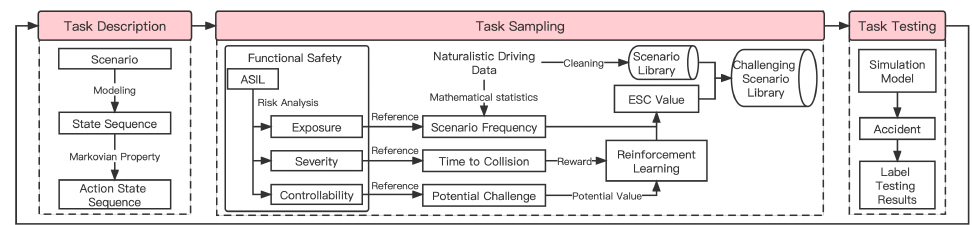
Figure 1. The system architecture of the proposed